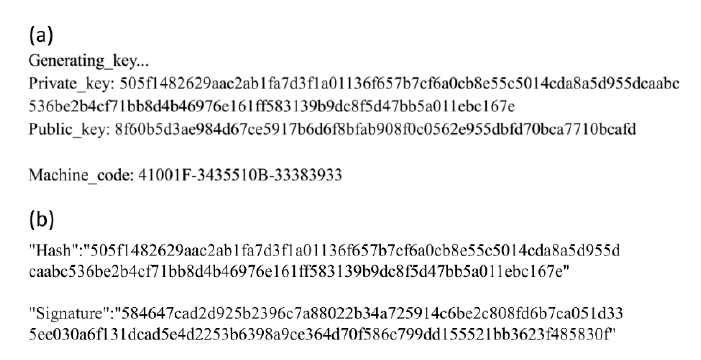
Figure 14. Related data generated by the portable smart spectrometer: ( a ) private key, public key, and machine code, ( b ) generated hash and digital signature.